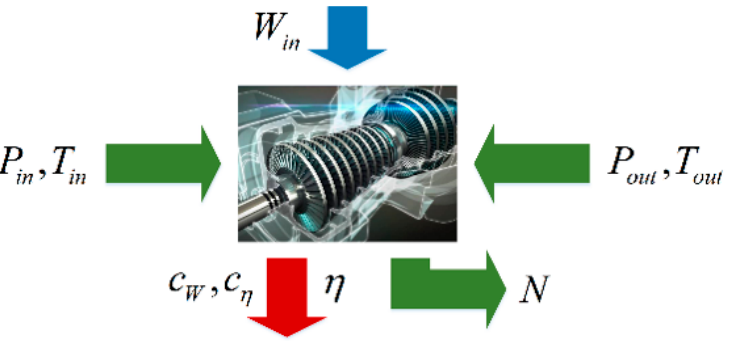
Figure 2. Compressor component inverse calculation.